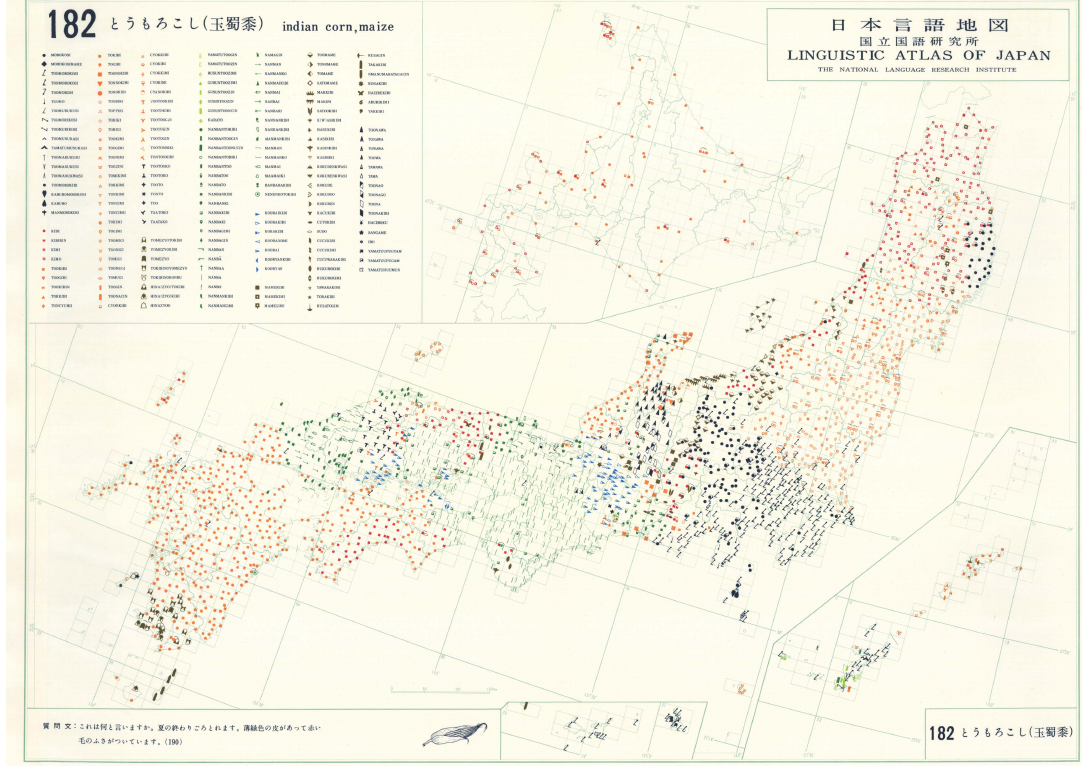
Figure 2. Example map from the LAJ (Nr. 182– ‘indian corn, maize’